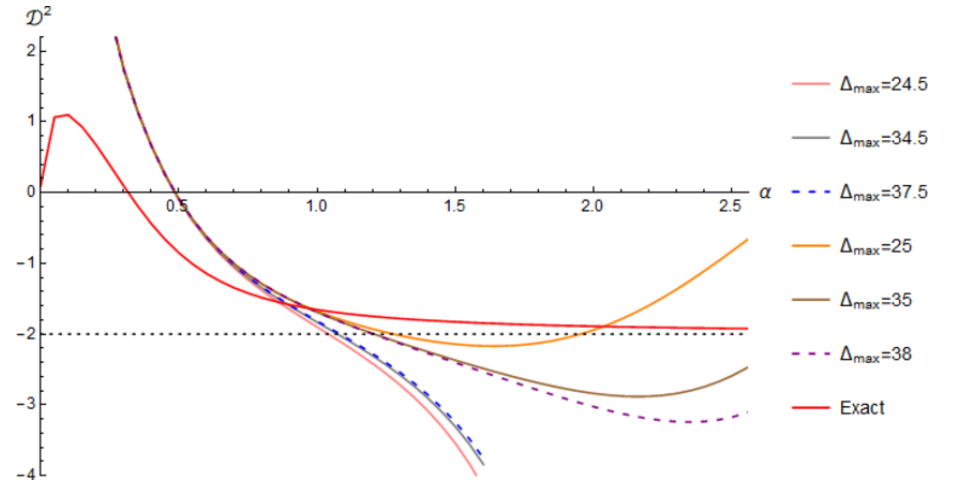
Figure 8. D 2 ( e 1 (cid:0) e 0 ) versus (cid:11) > 0 for the free